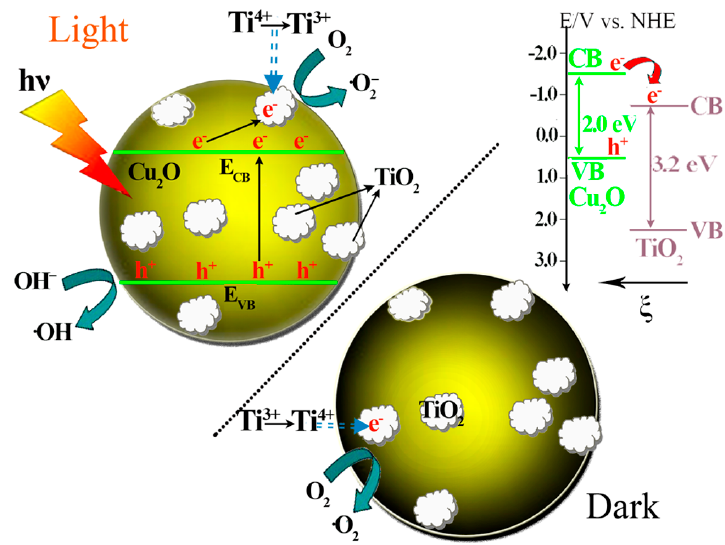
Figure 15. Proposed energy band structure of the Cu2O/TiO2 p ‐ n heterojunction, the photocatalytic activity enhancement mechanism under visible light illumination, and the post ‐ illumination catalytic memory mechanism in the dark. Reprinted with permission from [102]. Copyright American Chemical Society, 2014.